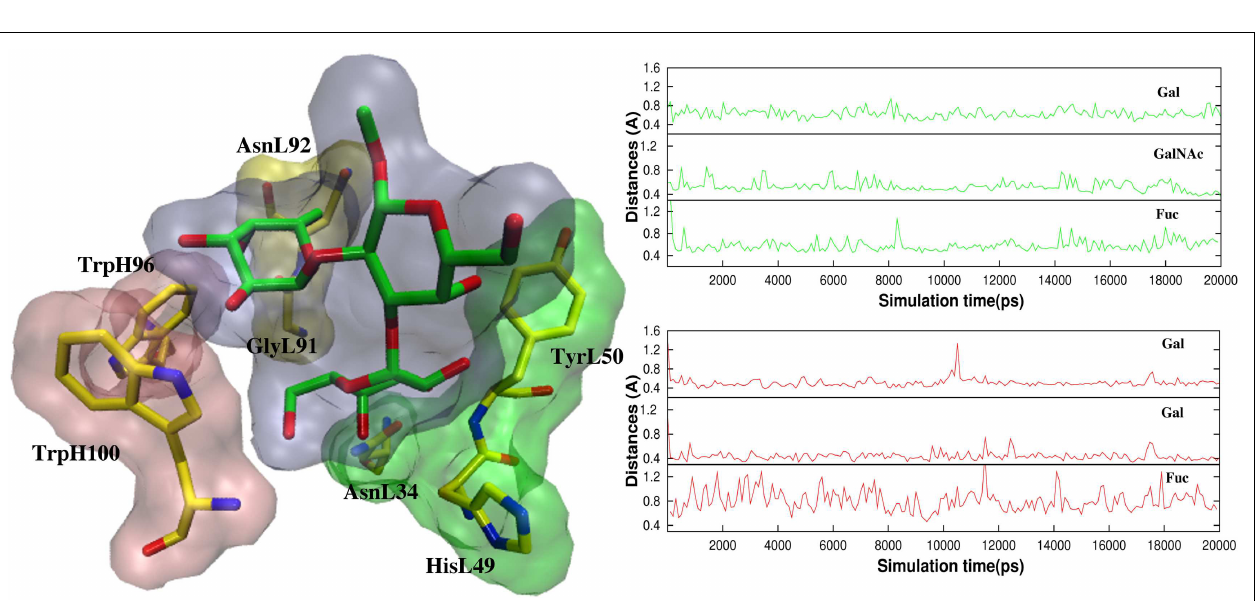
FIGURE 5 |Time series of the RMSD values for the ring atoms of the BGA (green) and BGB (from three independent simulations, blue, purple, and red) antigens, relative to the starting conformation of the complex .